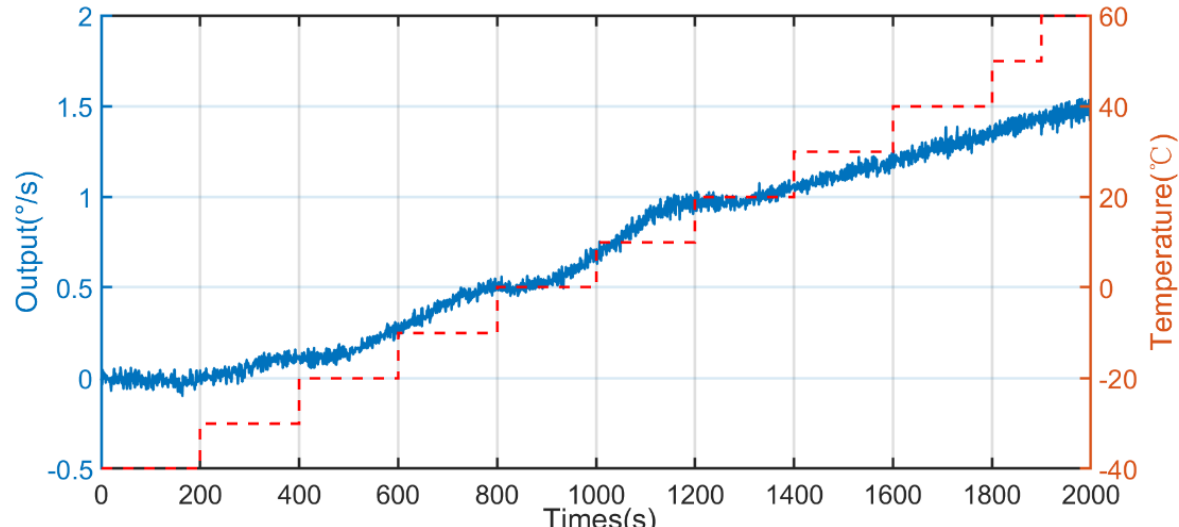
20 of 27 Figure 12. Process of the full relative humidity experiment. Based on the designed full-temperature experiment, data were collected at fixed